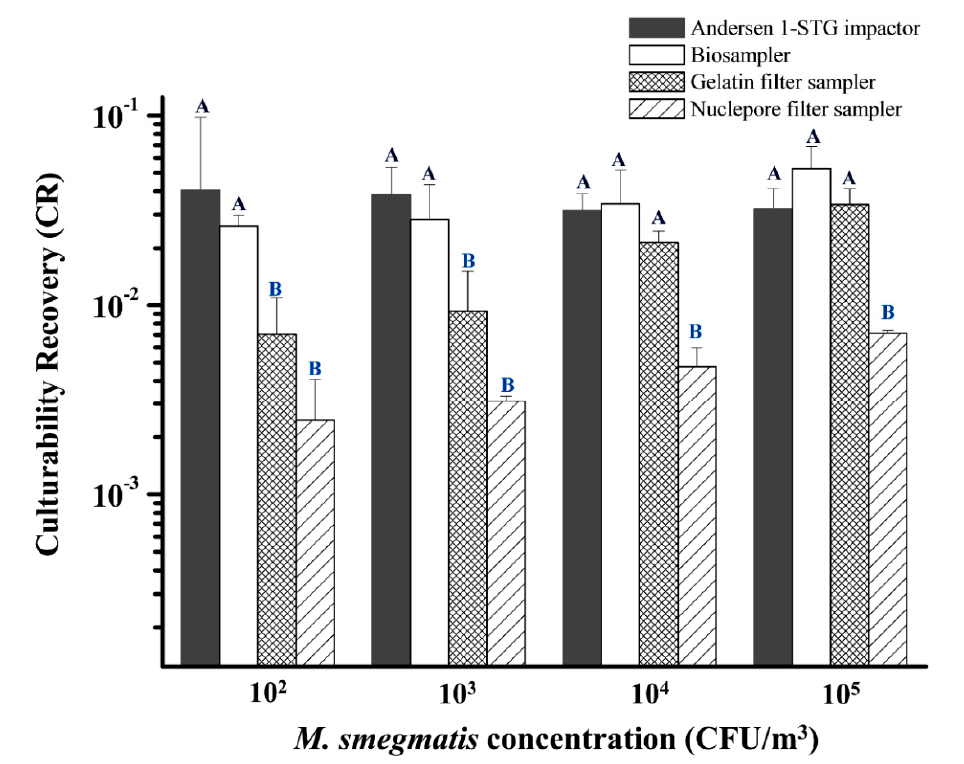
Figure 3. Relative culturable collection e ffi ciencies of bioaerosol samplers for capturing airborne M. smegmatis . The indicator CR was used to adjust the initial culturable concentration in the nebulizer to determine the biological performance of the tested samplers. Samplers with higher CR values can preserve more culturability of M. smegmatis under the sampling conditions. Samplers with the same letter (e.g., A versus A; B versus B) have similar CR values that are not significantly di ff erent ( p > 0.05, Dunn’s multiple comparison test). However, if samplers with di ff erent letter (e.g., A versus B), their CR values are significantly di ff erent. Experiments were performed in triplicate and the data shown represent the mean ± standard error of the mean.